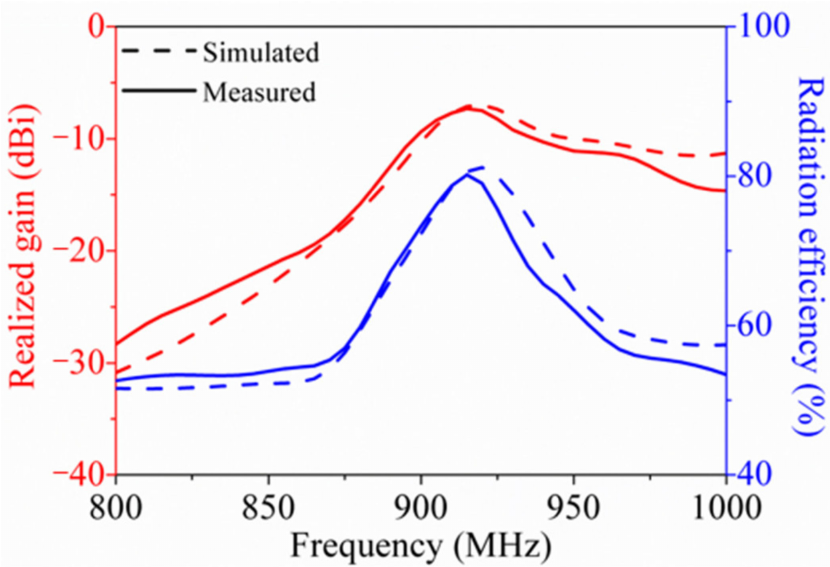
Figure 10. Simulated and measured realized gain and radiation efficiency of the